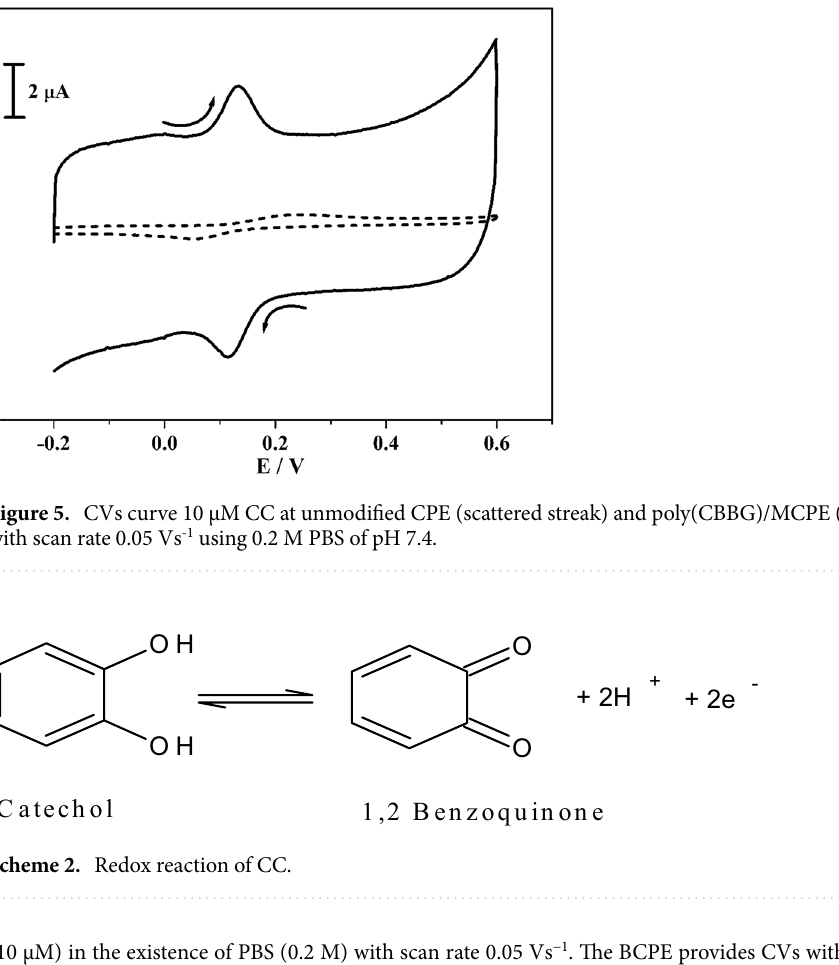
C atech ol 1 ,2 B en z oq u in on e Scheme 2. Redox reaction of